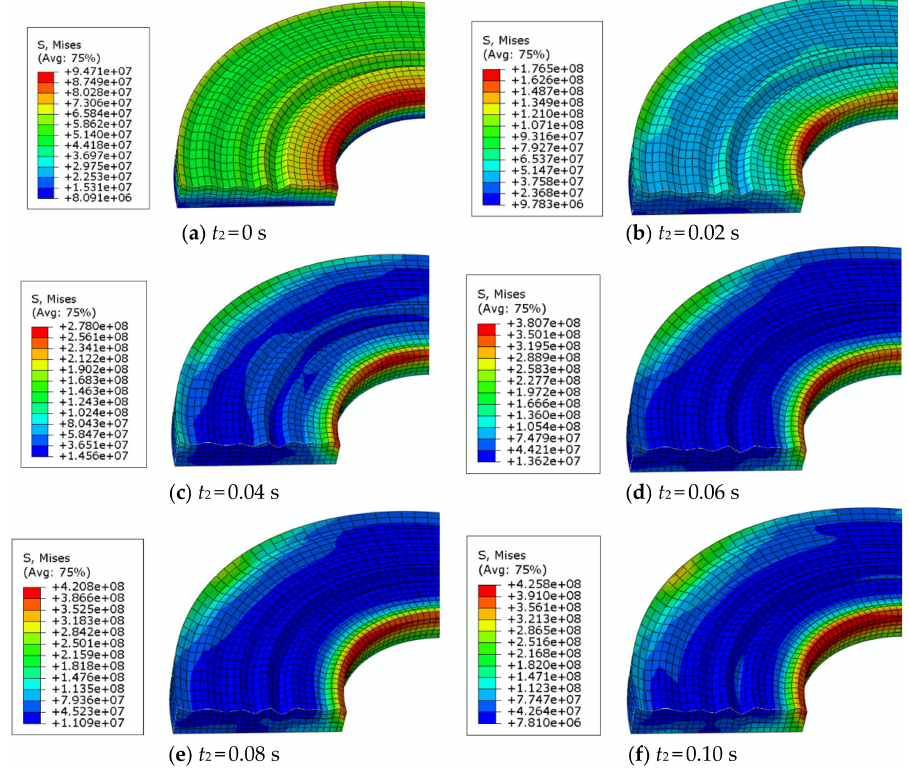
Figure 6. Stress of the upper rough